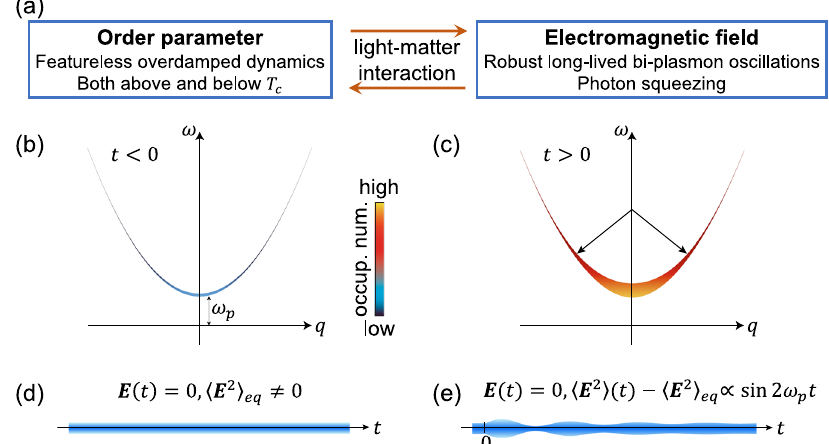
Fig. 1 Summary of the main results. a The two building blocks of the effective description of non-equilibrium superconductors are the order parameter and the electromagnetic fi eld in the sample, and the two entities are coupled. Upon photoexcitation, the electromagnetic fi eld displays periodic fl uctuation evolution, even if the order parameter dynamics is overdamped. b , c Schematic spectra of plasmons, which are gapped due to the Anderson-Higgs mechanism. Prior to photoexcitation ( b ), the plasmon distribution function is thermal; the thin blue curve captures the low occupation numbers. After photoexcitation ( c ), these plasmons proliferate (shown by the thick red-orange curve) through the creation of momentum-conserving pairs. d , e Schematics of time evolution of the electric fi eld in the sample, which always has a zero expectation value. In equilibrium ( d ), the electric fi eld has a non-zero thermal variance h E 2 i eq . After an impulsive optical quench ( e ), this variance becomes periodically modulated, with the frequency 2 ω p being twice the plasmon